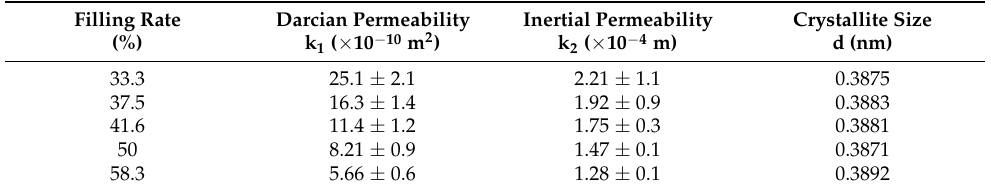
Table 2. Permeability constants and crystallite size of C WCMs sample with different filling rate under a constant resin concentration of 30%.